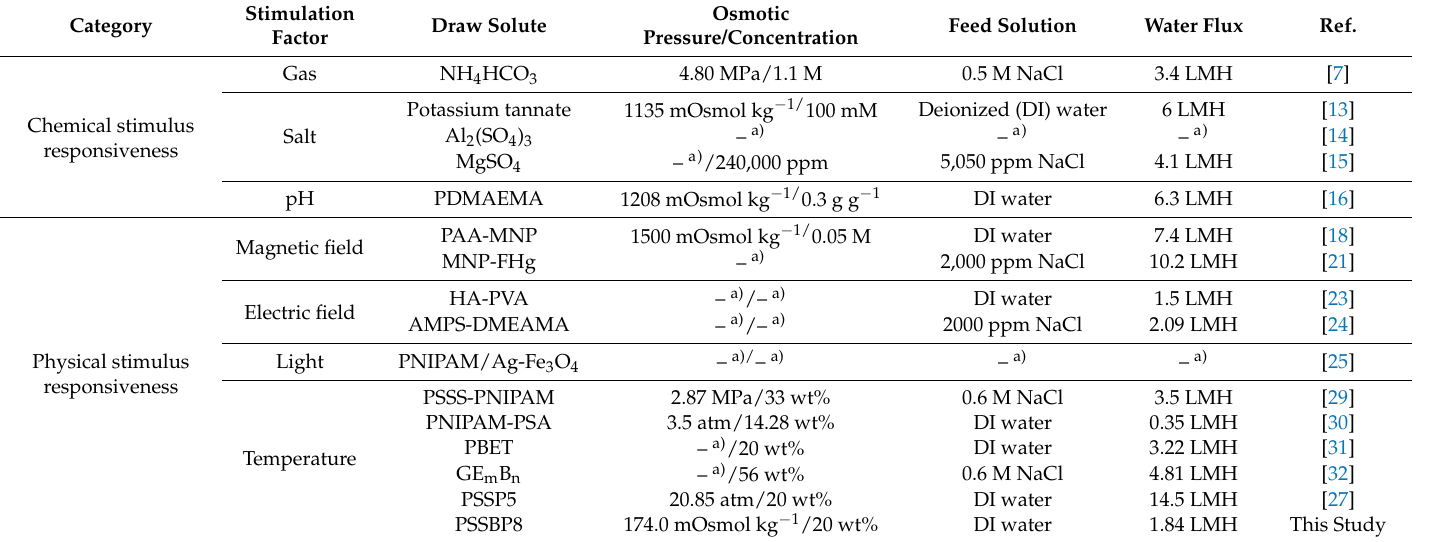
Table 1. Overview of previous research about external-stimulus-responsive draw